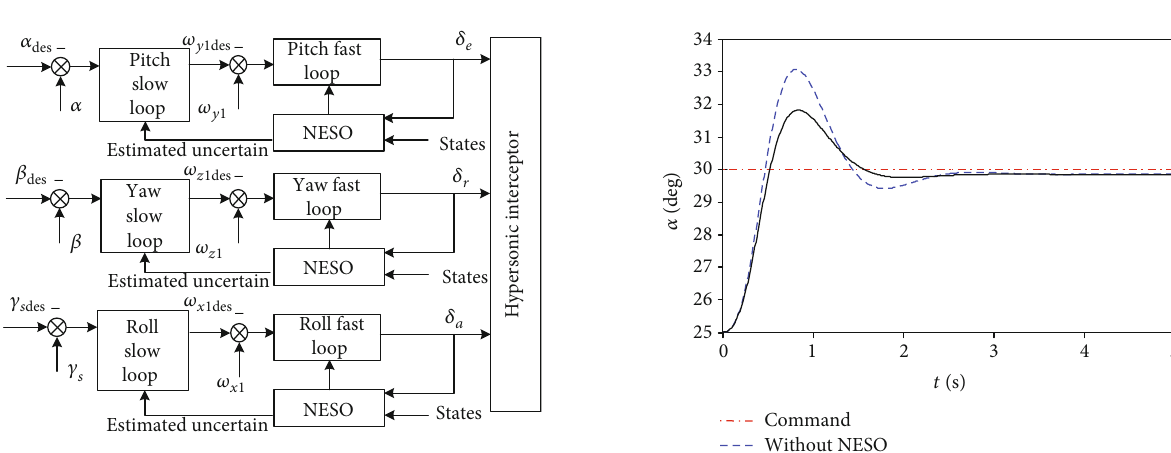
Figure 5: Hypersonic glide vehicle ’ s decoupling control block diagram.